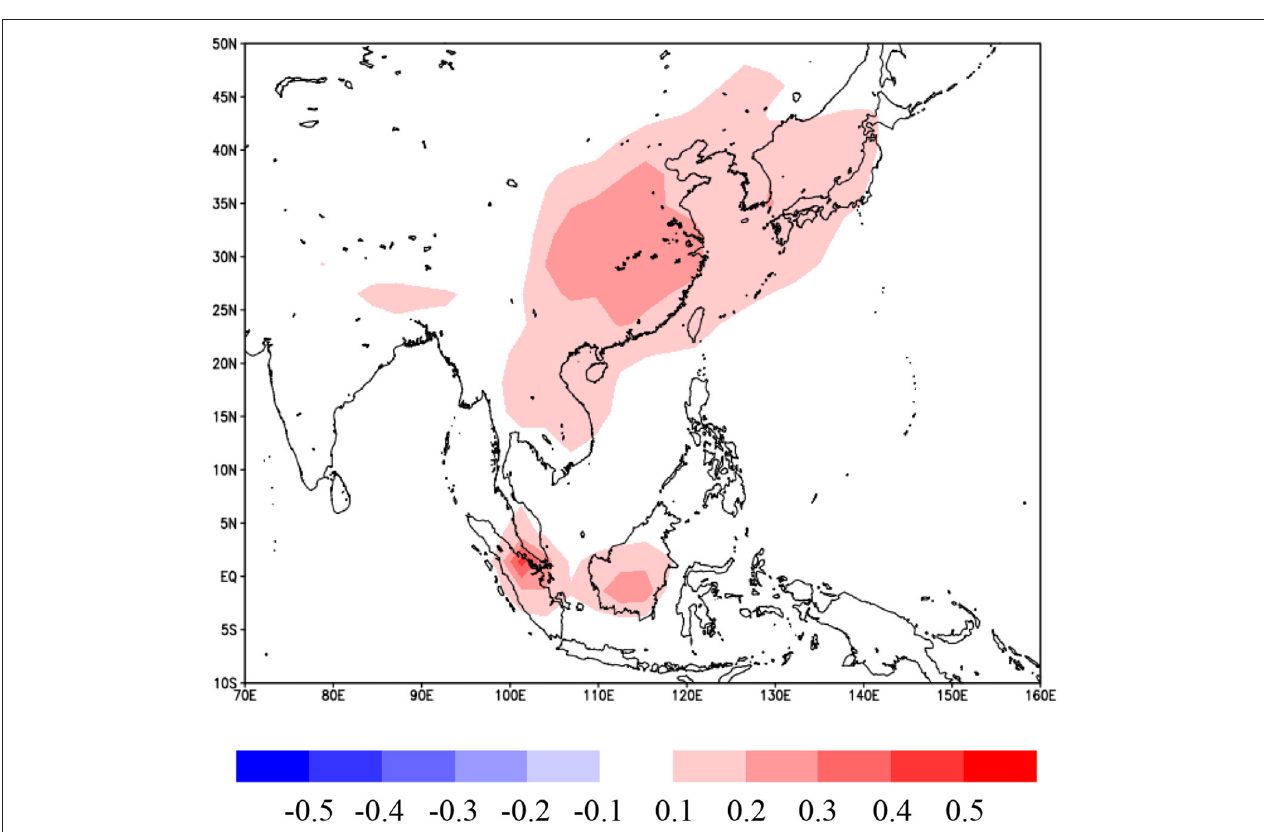
FIGURE 10 | Distribution of the difference between 5-year mean of AOT (0.55 µ m) averaged from 2001 to 2005 estimated by subtracting no aerosol forcing simulation from historical